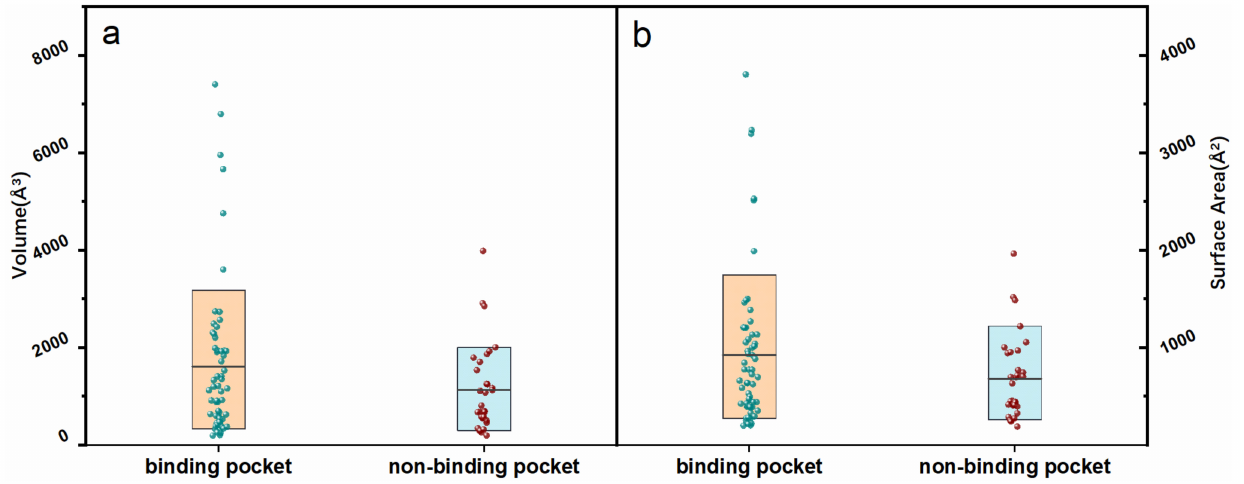
Figure 4. The geometric information distribution of surface area ( a ) and volume ( b ) for RNA-binding pockets and -non-binding pockets. Boxes in ( a , b ) represent the 80% core distributions (ranging from 10th to 90th percentile). The black lines on the box represent the average